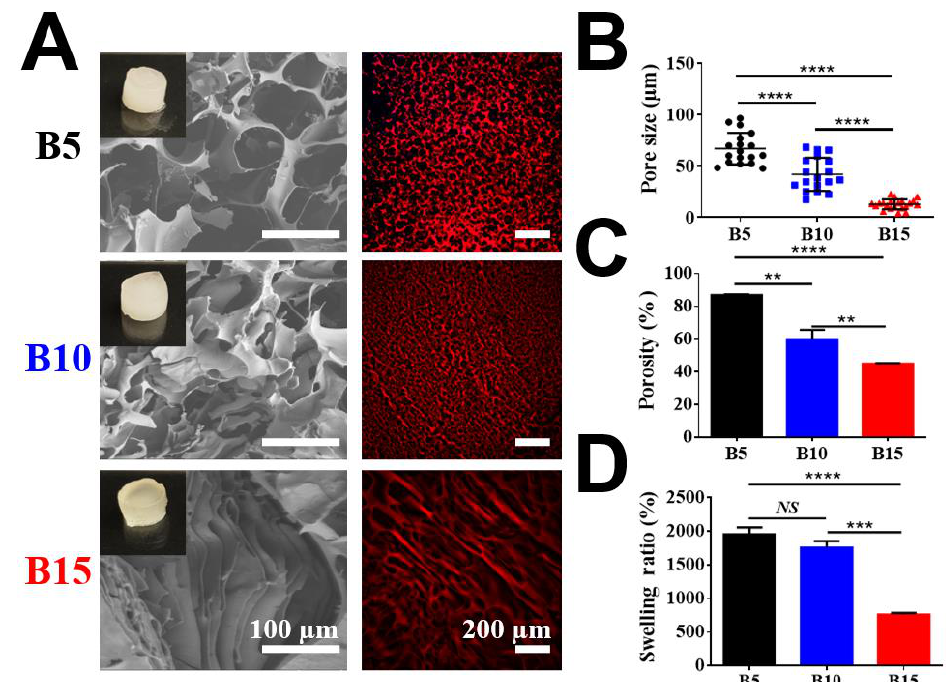
Figure 2. Physical characterization of three BSAMA cryogels (B5, B10, and B15). ( A ) Scanning electron microscopic (SEM) and confocal microscopic images (red: the wall of cryogels). Scale bar: 100 µ m in SEM; 200 µ m in confocal. ( B ) Pore size distribution. Black circles, blue squares, and red triangles represent the pore sizes of B5, B10, and B15, respectively. ( C ) Pore connectivity was demonstrated as a porosity (%). ( D ) Swelling ratio. n = 3, **: p < 0.01, ***: p < 0.005, ****: p < 0.001, NS means no significant difference between the samples at the extremities of the line. 18 pores were counted in every kind of BSAMA cryogels.